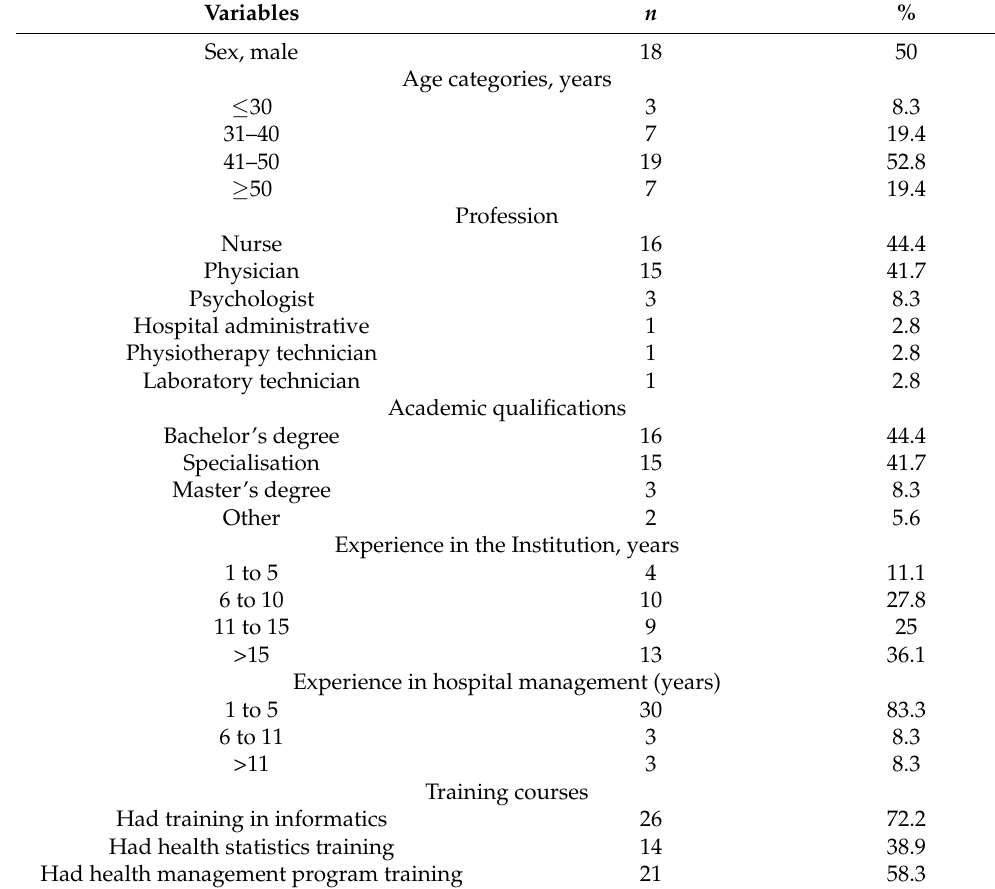
Table 2. Characterisation of the participants’ profiles ( n = 36).